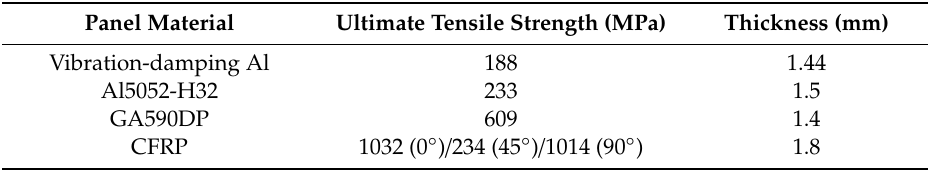
Table 1. The ultimate tensile strength and thickness of the materials tested here. The results for three di ff erent directions (0 ◦ , 45 ◦ , and 90 ◦ ) are shown for carbon-reinforced plastic